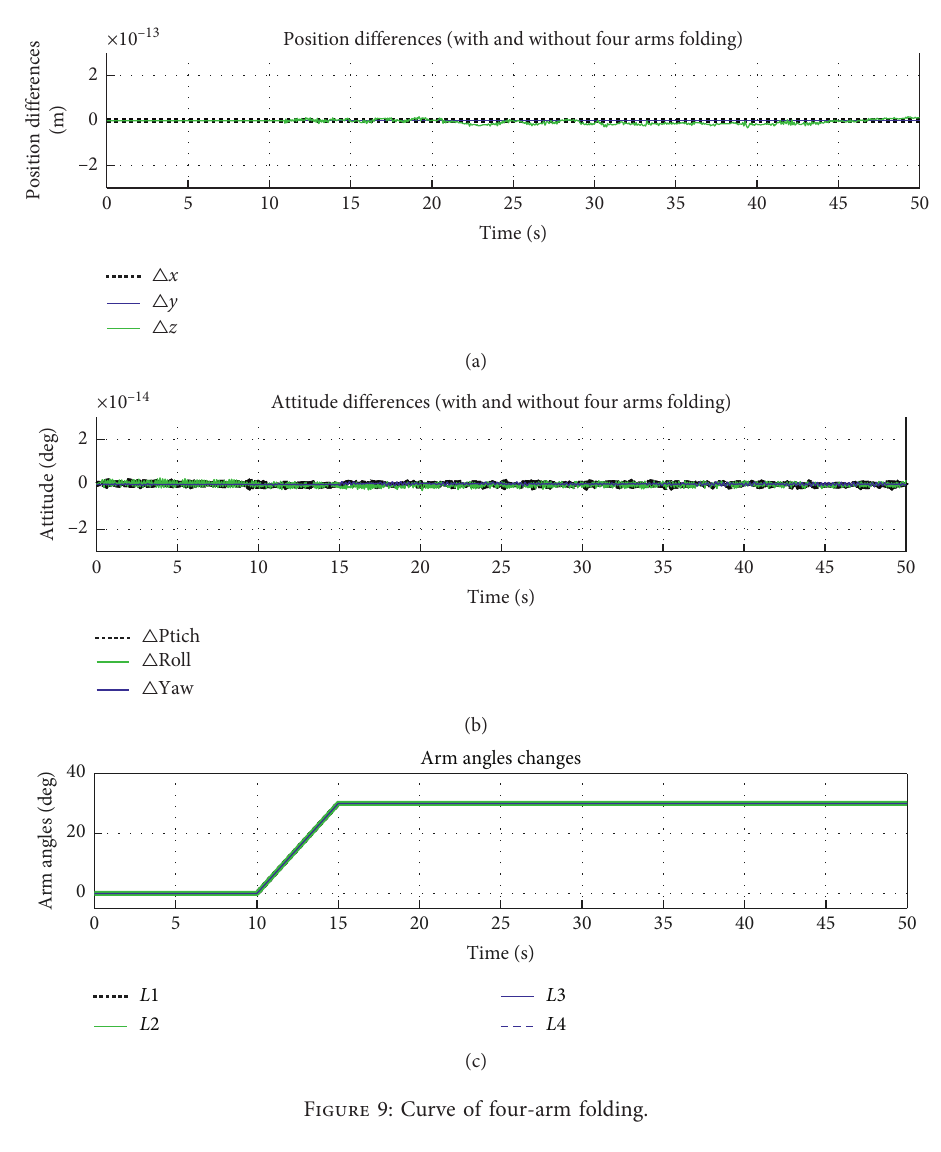
Figure 9: Curve of four-arm folding.